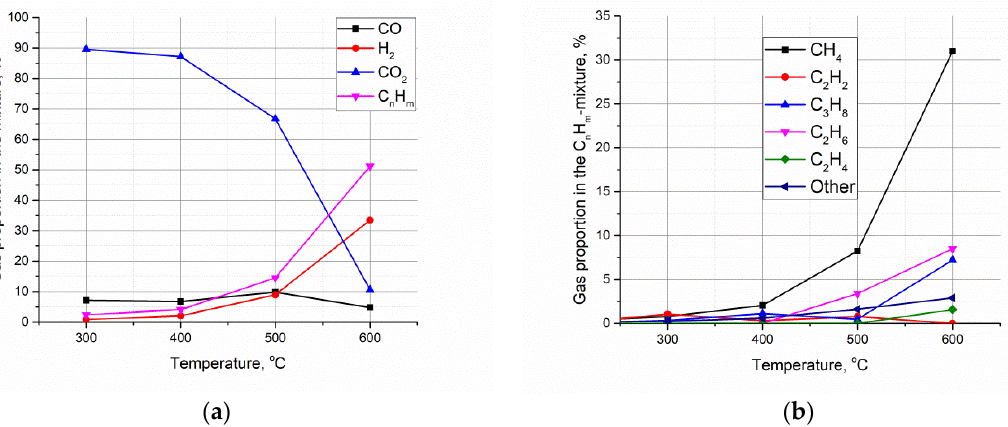
Figure 2. Dependence of the composition of non-condensable pyrolysis gases ( a ) and hydrocarbon gas mixture (CnHm) ( b ) on the feedstock heating temperature.